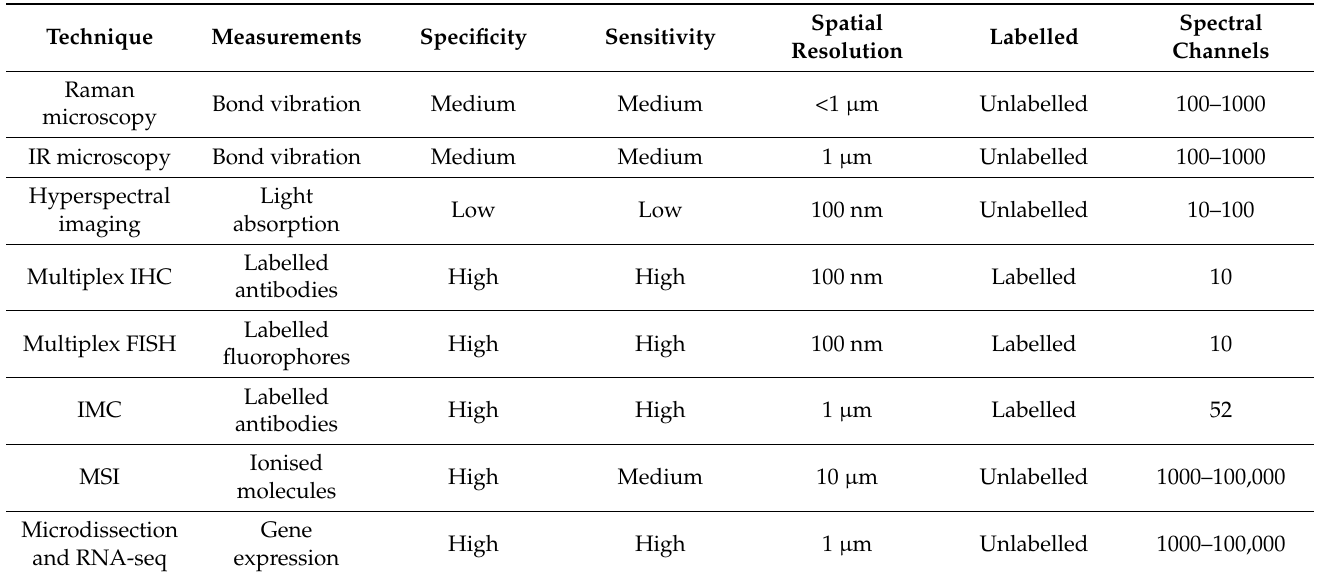
Table 1. Summary of different techniques that can be used for molecular pathology, and their key properties relevant to clinical diagnostics for digital